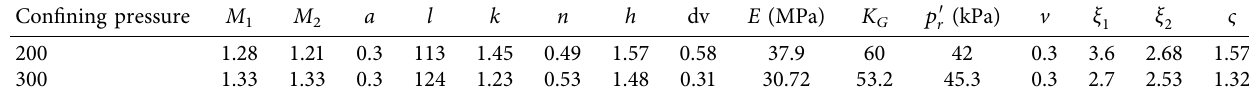
Table 5: The parameters for silted soil in front